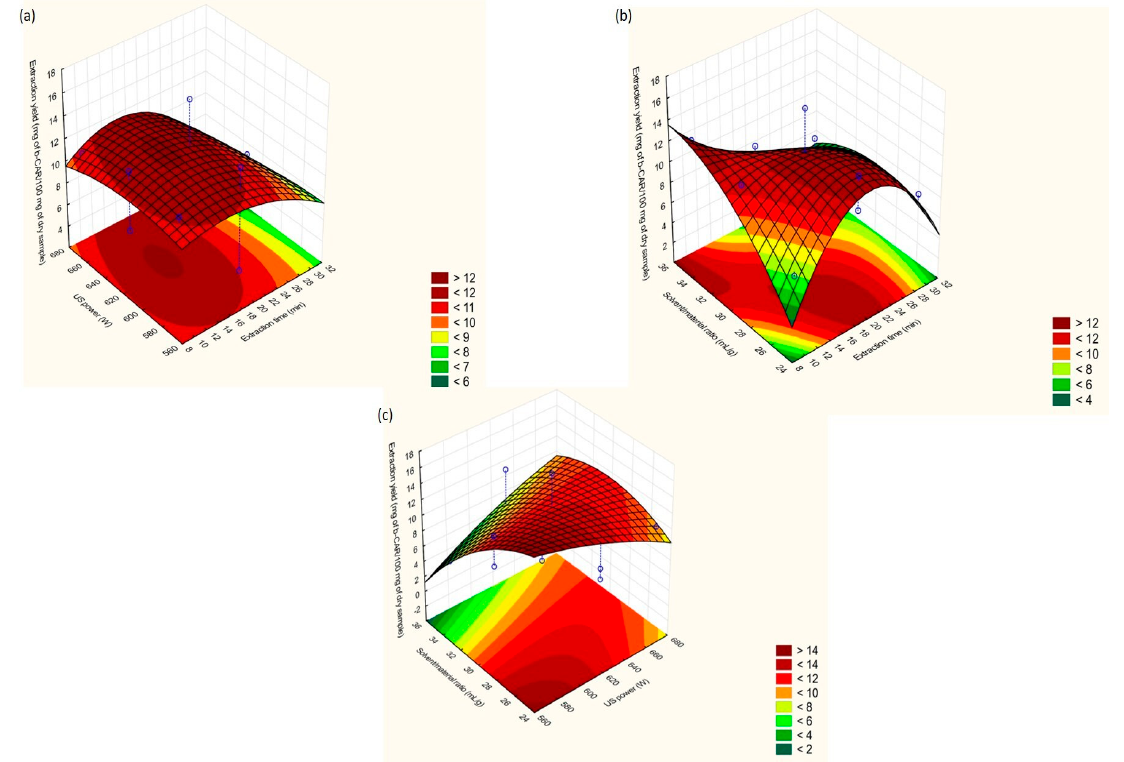
Figure 3. Response surface methodology (RSM) plots for UAE: ( a ) extraction time vs. US power; ( b ) US power vs. solvent/material ratio; ( c ) solvent/material ratio vs. extraction time.